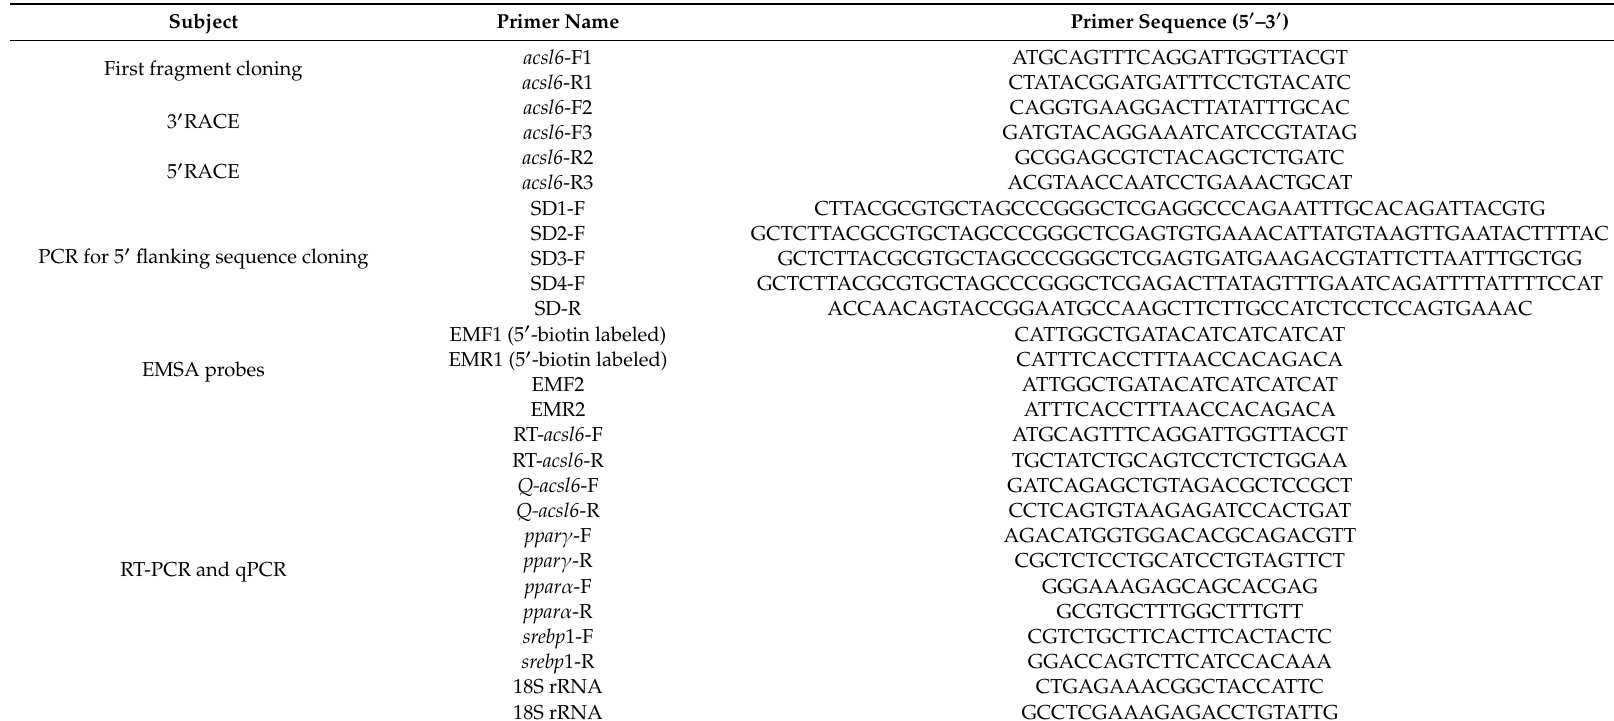
Table 2. PCR primers sequence and RNAi nucleotide sequence used in this